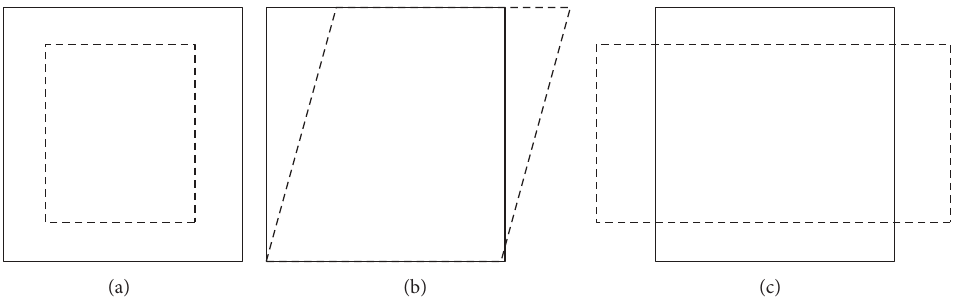
Figure 2: Schematic illustration of volume change (a) and shape distortion (b, c) [10].